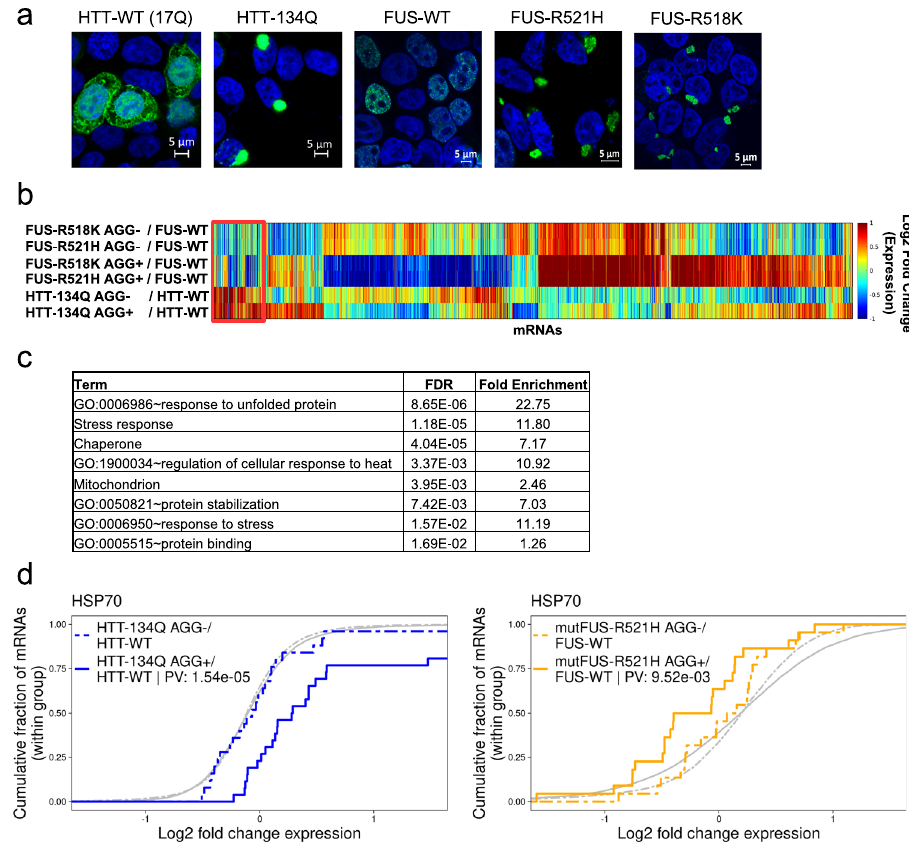
Fig. 1 HTT-polyQ aggregation elicited a cellular proteotoxic stress response while mutFUS led to deteriorated proteostasis. a HEK293T cells transfected with HTT-17Q-GFP (HTT-WT), HTT-134Q-GFP, FUS-WT-YFP, FUS-R521H-YFP or FUS-R518K-YFP, were imaged 48 h following transfection using confocal microscopy. Cells were stained with DAPI to mark nuclei (blue). Shown are representative images from n = 5/14/1 biologically independent experiments for HTT (-WT and -134Q)/FUS (-WT and -R521H)/FUS-R518K, respectively. b Hierarchical clustering analysis of RNA-seq Log2 Fold Change (LFC) values of HTT-134Q and mutFUS aggregation experiments, where aggregate-containing cells (AGG + ) and non-aggregated mutant protein cells (AGG − ) were sorted using FACS. Each mutant was compared to its respective WT which had undergone the same sorting procedure (see “ Methods ” ). c Pathway enrichment analysis for the red cluster showed enrichment of groups related to proteotoxic stress responses and chaperones. d Expression of genes belonging to the HSP70 family was signi fi cantly induced in cells containing HTT-134Q aggregates, and signi fi cantly reduced in mutFUS aggregate- containing cells. Plots show the cumulative distribution function (CDF, y -axis) of the LFC values of mRNAs belonging to the HSP70 family de fi ned in Brehme et al. 52 (see “ Methods ” ), and are shifted compared to the background CDF of all expressed mRNAs (in gray) in the HTT-134Q AGG + sample (solid blue) and FUS-R521H-YFP AGG + sample (solid yellow), but not in the HTT-134Q AGG- sample (dashed blue) or the mutFUS AGG − samples (dashed yellow). CDF plots for FUS-R518K-YFP showed the same trend (Supplementary Fig. 2e). P -values for the differences of each sample compared to the background distribution were calculated using t-test, and indicated in the legend when signi fi